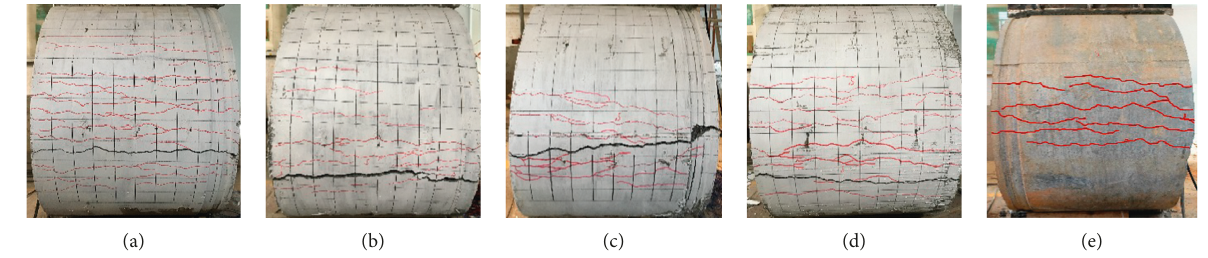
Figure 4: Crack distribution of the specimens: (a) RCP; (b) RGC; (c) RGS; (d) RGH; (e)